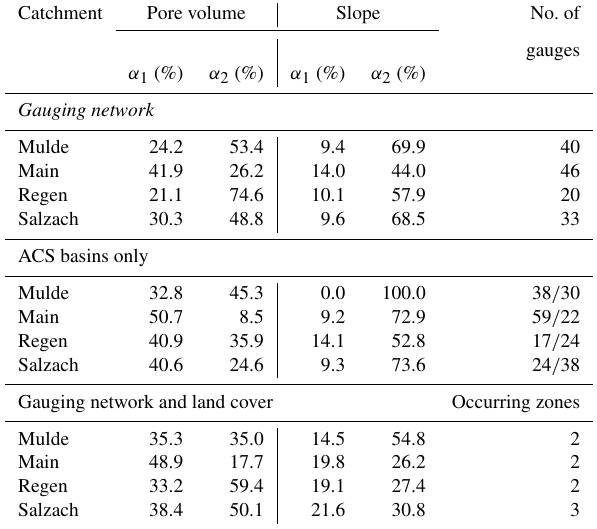
Table 3. Normalized reduction of standard deviation for sub-basins based on gauging network, ACS basins, and gauges and land cover. Catchment Slope No.